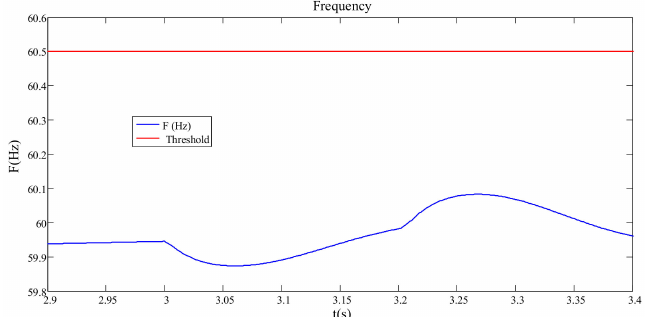
Figure 11. The output of OF / UF relay in short circuit fault.